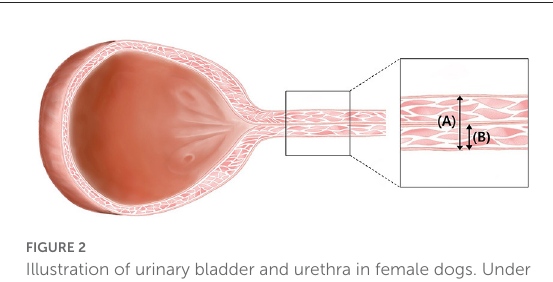
FIGURE2 Illustration of urinary bladder and urethra in female dogs. Under normal conditions, the lumen of the urethra is not dilated. It is reasonable to assume that the “total urethral thickness” (A) is twice the “urethral wall thickness” (B)